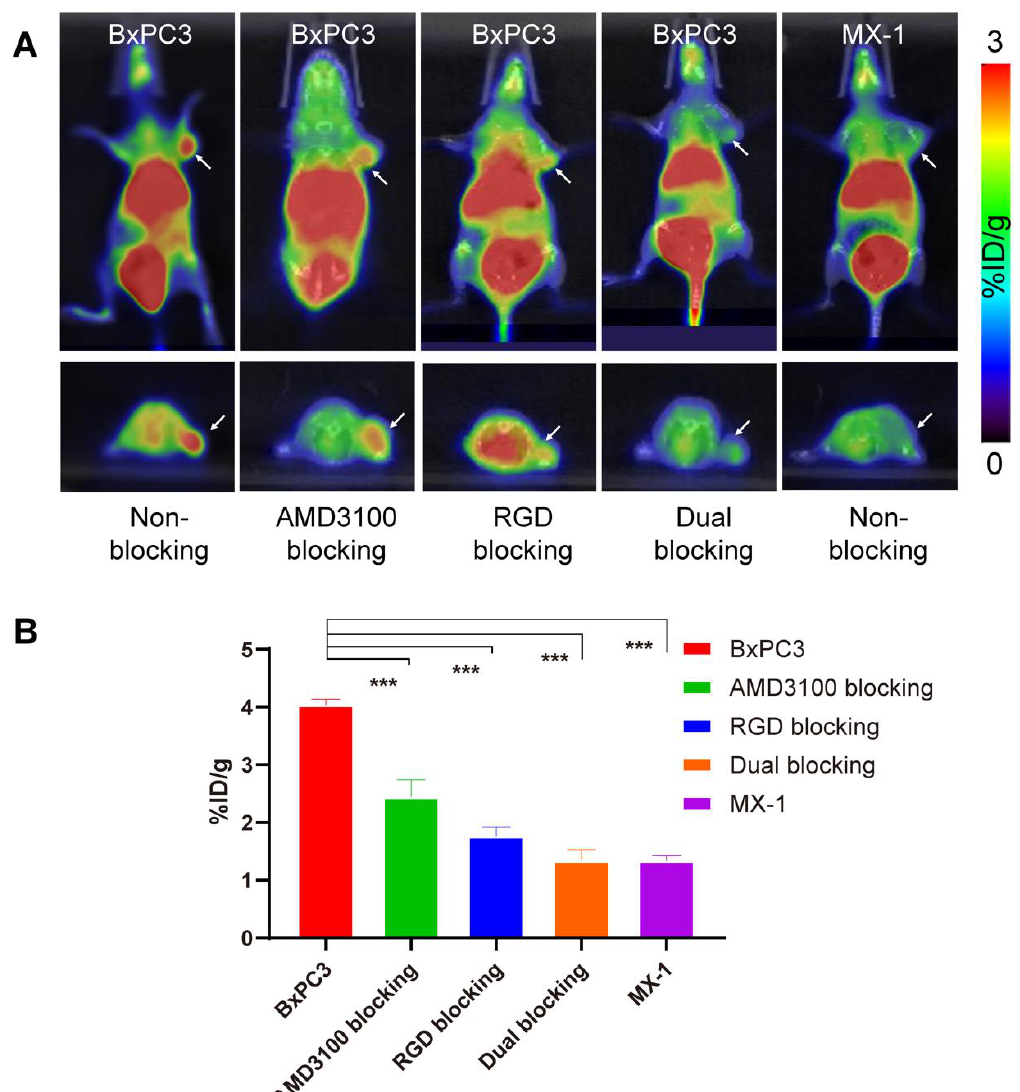
Figure 3. PET imaging and quantitative analysis show the specificity of 68 Ga-yG5-RGD for CXCR4 and integrin α v β 3 expression on tumors. ( A ) Decay-corrected whole-body small animal PET/CT images of BxPC3 or MX-1 tumor-bearing mice at 30 min after injection of 5.55–7.4 MBq of 68 Ga-yG5- RGD and a blocking dose of AMD3100 (10 mg/kg), RGD (10 mg/kg), or AMD3100 (10 mg/kg) + RGD (10 mg/kg). ( B ) Tumor uptakes determined by quantitative ROI analysis of PET/CT images. Arrows indicate the location of tumors, n = 4; *** p < 0.001.